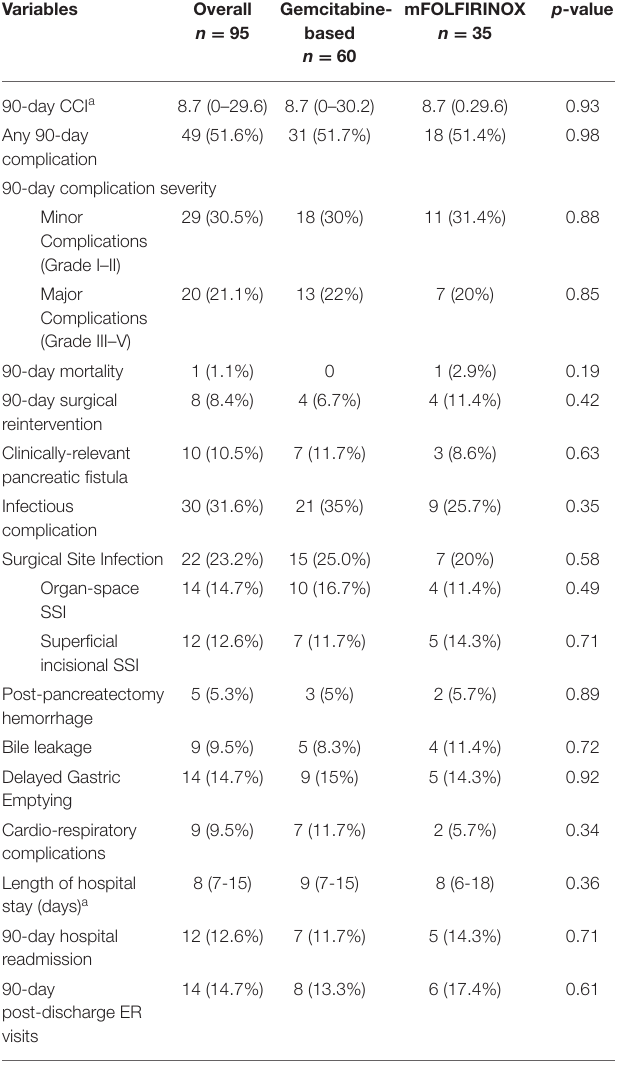
TABLE 7 | Postoperative outcomes in neoadjuvant group stratified by chemotherapy regimen.